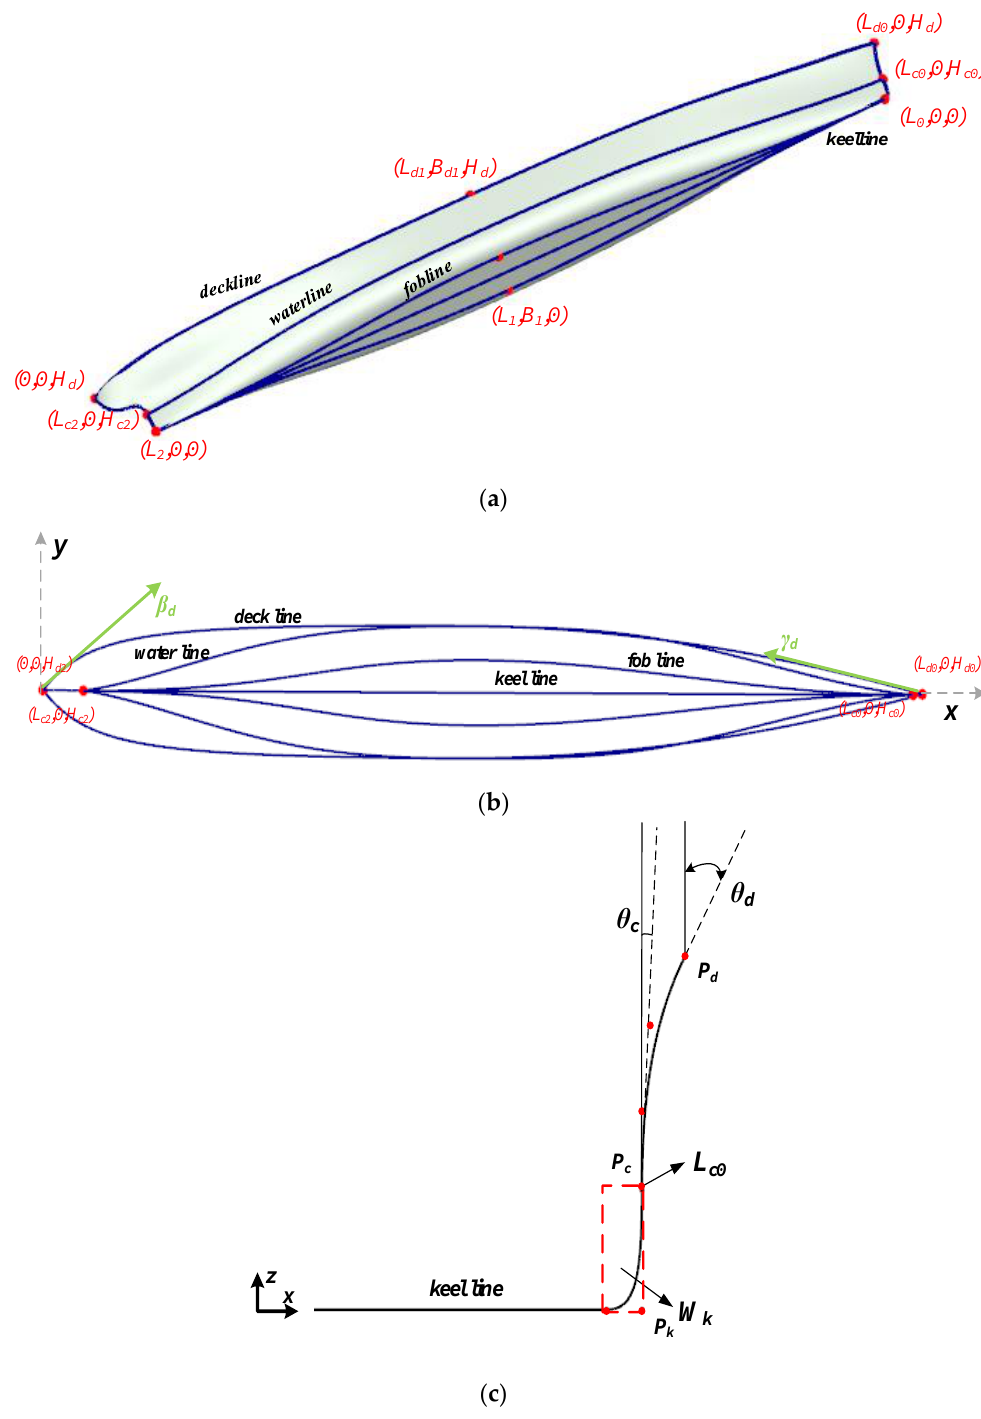
Figure 5. Geometric meanings of the second category of feature parameters. ( a ): parameters of the point positions of the ship; ( b ): parameters in the xy plane. ( c ): parameters in the xz plane. In the length direction, L d 0 and L d 1 are the x -coordinates of the front end of the deck line and the point at the maximum breadth amidships, respectively, and the x -coordinate of the rear end point is always 0; L c 0 and L c 2 are the x -coordinates of the front and rear end of the waterline, respectively. Finally, L 0 , L 1 , and L 2 are the x -coordinates of the front end point, the point at the maximum width, and the rear end point of the flat-bottomed line, respectively. In the width direction, the first and last ends of the deck line, waterline, and flat-bottomed line intersect with the mid-longitudinal section, so the y -coordinate of each one is 0. The waterline and deck line have equal width, represented by B d 1 amidships; parameter B 1 is the maximum breadth of the flat-bottomed line amidships. Similarly, in the height direction, since the flat-bottomed line is located on the baseline, its z- coordinate is 0, which is a fixed value; the heights of the head and tail ends of the waterline are ex- pressed by H c 0 and H c 2 , respectively, while the height of the deck line is expressed by H d . In addition to the three parameters of length, width, and height, there are also control parameters of angle and weight factors. The angle is introduced in three views: section, profile, and plan view. Here, the angle between the tangent line of the cross-section curves at the deck and the waterline and the z -axis is controlled by the longitudinal feature curves. The curves are designed as the front and rear parts, and their maximum values in the front and rear parts of the hull are taken as the feature parameters (the specific values are designed when generating the longitudinal feature curves), which are denoted as α b , α f , and δ b , δ f (the same geometric meanings as α and δ in Figure 6, where they are indicated as the maximum values). Figure 5c shows the keel line diagram of the bow of the hull in the profile view ( xz plane), where θ c and θ d are the angles between the tangent lines (dashed lines) of the keel line at P c and P d , respectively, and the z -axis. Figure 5b shows